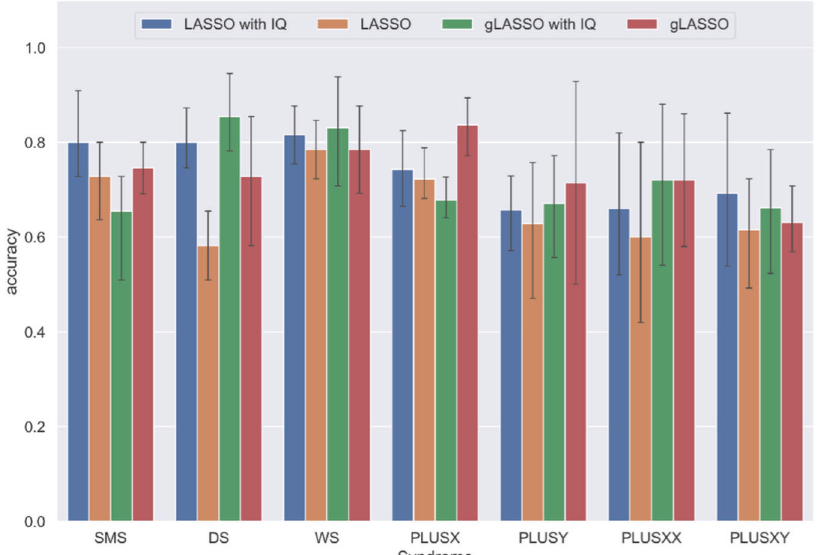
Fig. 5 Average prediction accuracy for each GDD group achieved by each of the four machine learning (ML) models. All the models yield plausible (above chance) prediction accuracy. Without IQ, group LASSO with 65 items performs better than LASSO with 5 subscales for most of the GDD groups except WS where their prediction accuracies are similar. With IQ information, the comparison of ML model performance with 65 items vs. 5 subscales varies across the GDD groups. The error bar indicates 95% con fi dence interval of the 1000 bootstrap samples across the 5-fold cross-validation.